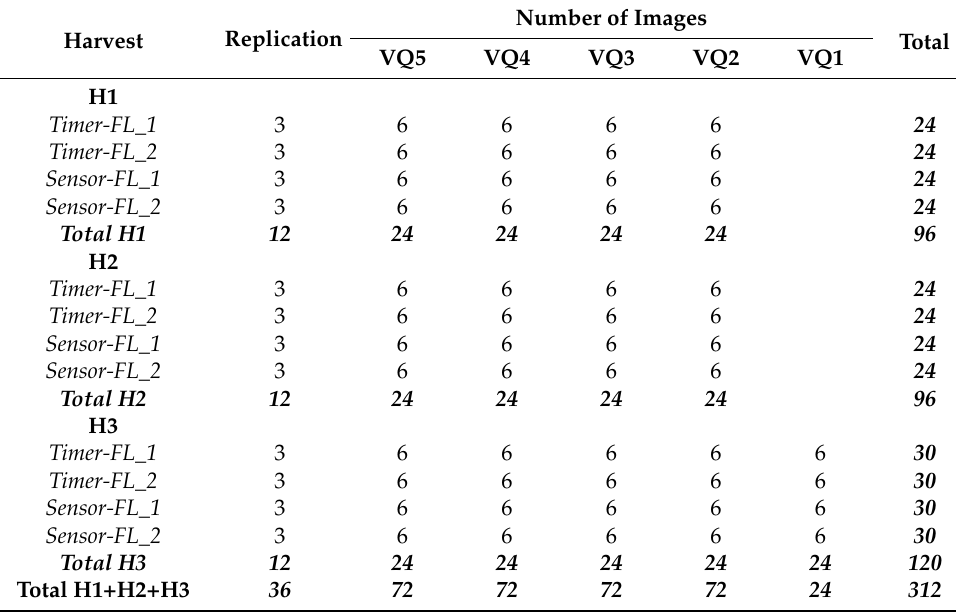
Table 1. Composition of the training set of images with respect to harvests (H1, H2 and H3),